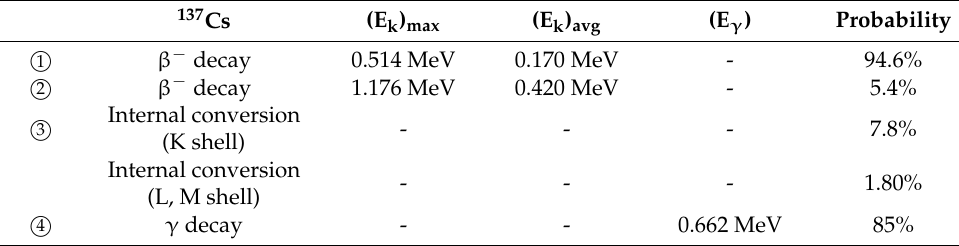
Figure 1. Decay of diagram of 137 Cs. Table 1. β − decay process, electron energy, and probability of Cs-137.